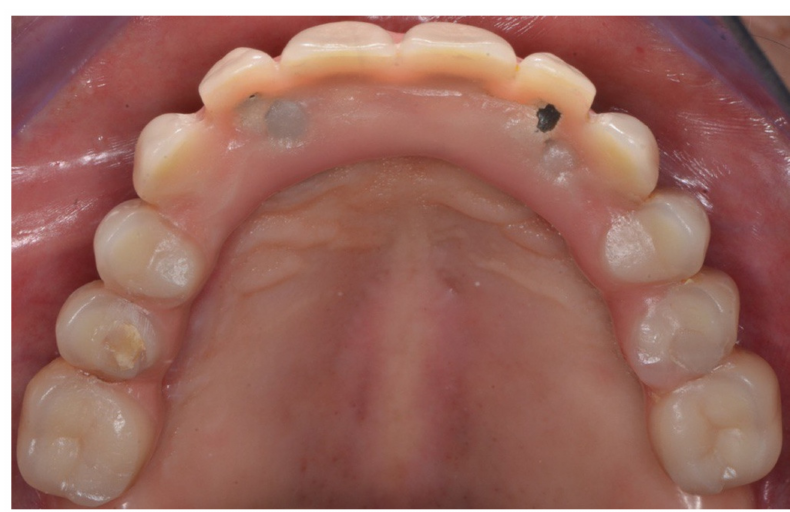
Figure 7. Occlusal view of definitive prosthesis after 7 years of use.